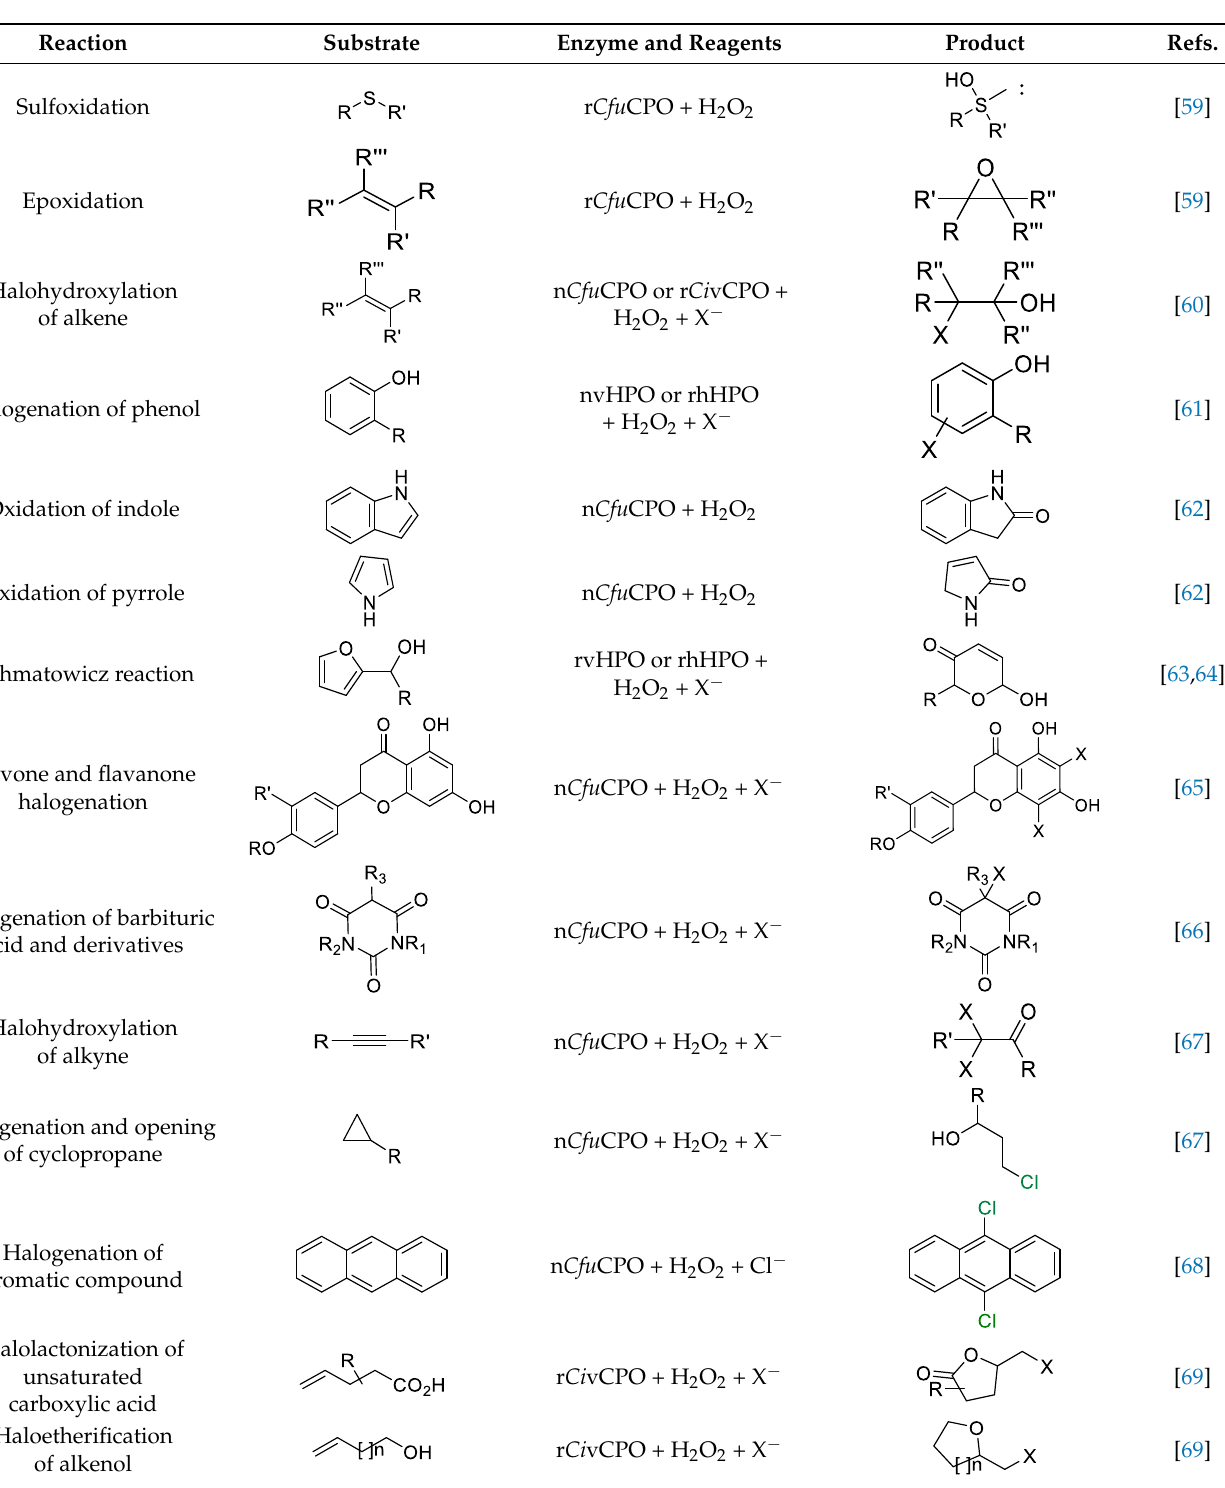
Table 3. Enzymatic halogenation catalyzed by some fungal flavin-dependent halogenases (r: recom- binant protein).